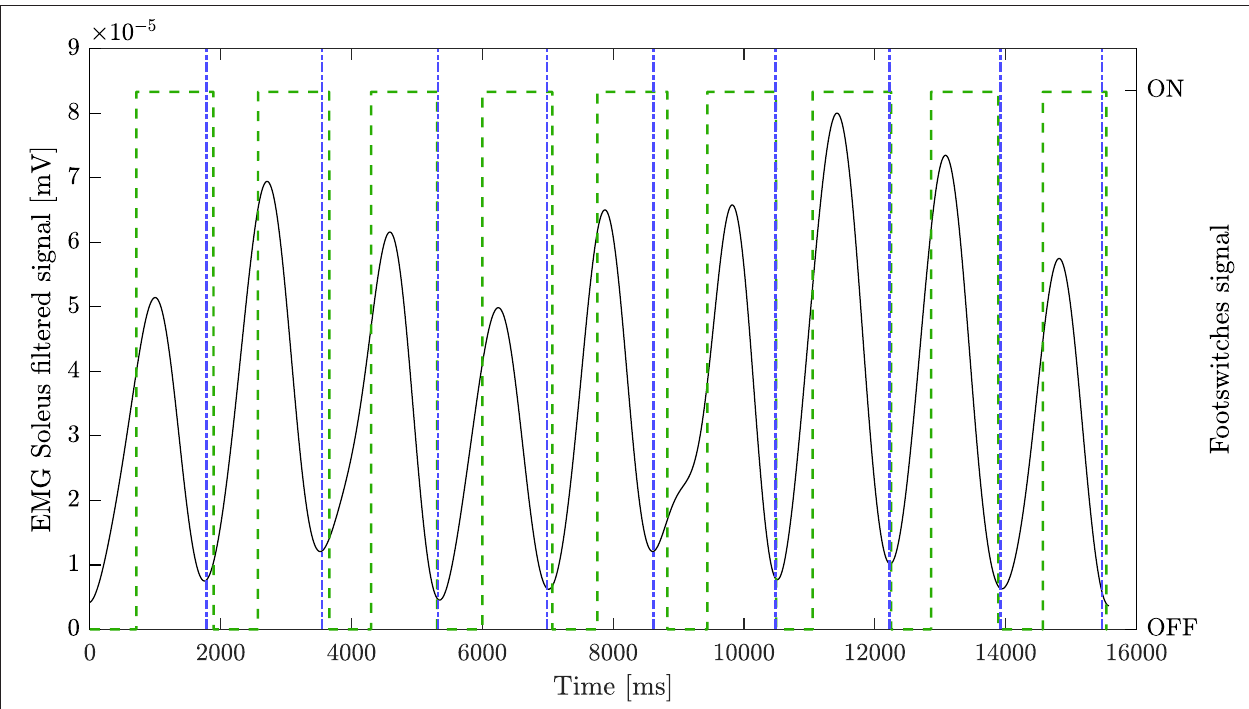
FIGURE 1 | Step segmentation algorithm results. Black line represents the pre-processed soleus (SOL) signal of the non-paretic leg, green dashed line represents footswitch signal placed under the shoe of the patient, blue dash-dot line represents EMG-based step segmentation.